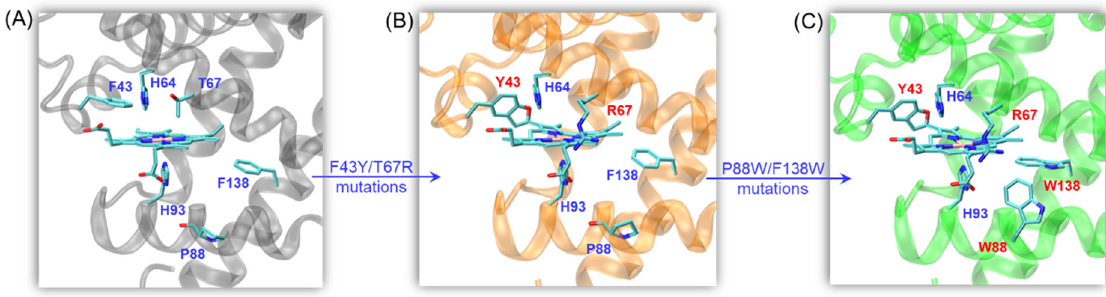
Figure 1. ( A ) X-ray crystal structure of wild-type (WT) Mb (PDB code 1JP6[35]) showing the heme active site; ( B ) X-ray crystal structure of F43Y/T67R Mb double mutant showing the double Tyr- heme cross-links (PDB code 6JP1[26]); ( C ) The modeling structure of F43Y/T67R/P88W/F138W Mb quadruple mutant showing the location of Trp88 and Trp138.